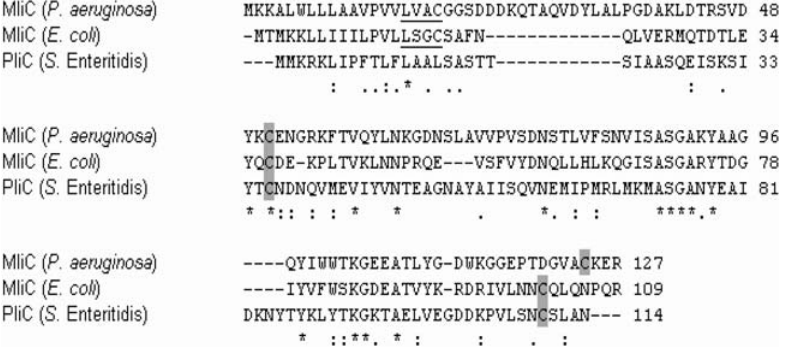
Figure 4. Amino acid sequence alignment of new HEWL inhibitors. Amino acid sequence alignment (http://www.ebi.ac.uk/clustalw/, [37]) of MliC from P. aeruginosa ( = PA0867 from P. aeruginosa PA01), MliC from E. coli ( = YdhA from E. coli MG1655) (both proteins containing the COG3895 domain) and PliC from S. Enteritidis ( = SEN1802 from S. Enteritidis). Residues that are identical in all sequences in the alignment are marked with ‘‘*’’ in the bottom row, conserved and semi-conserved substitutions with ‘‘:’’ and ‘‘.’’ respectively. The lipobox of the lipoproteins is underlined, while cysteine residues of the mature protein are highlighted in grey.